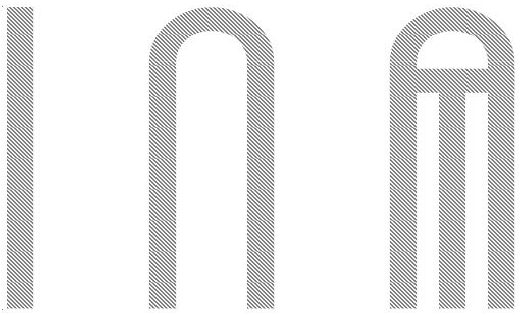
Figure 1. Shapes of straight, U-shaped, and multi-model